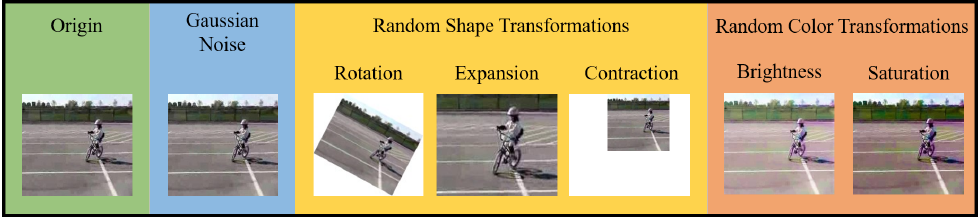
Figure 3. Visualization of different video augmentations introduced in